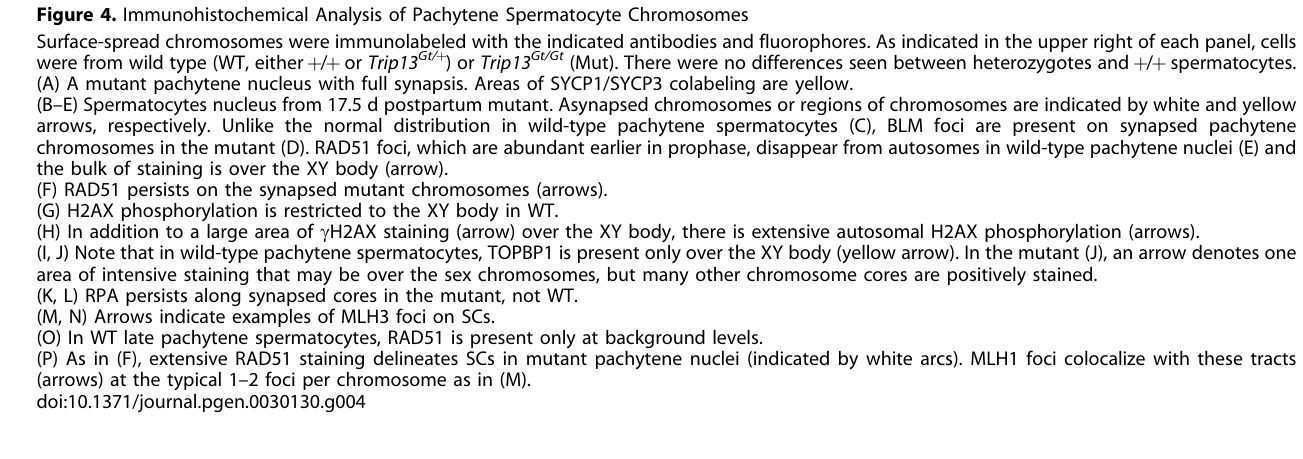
(Figure S2E and S2F).